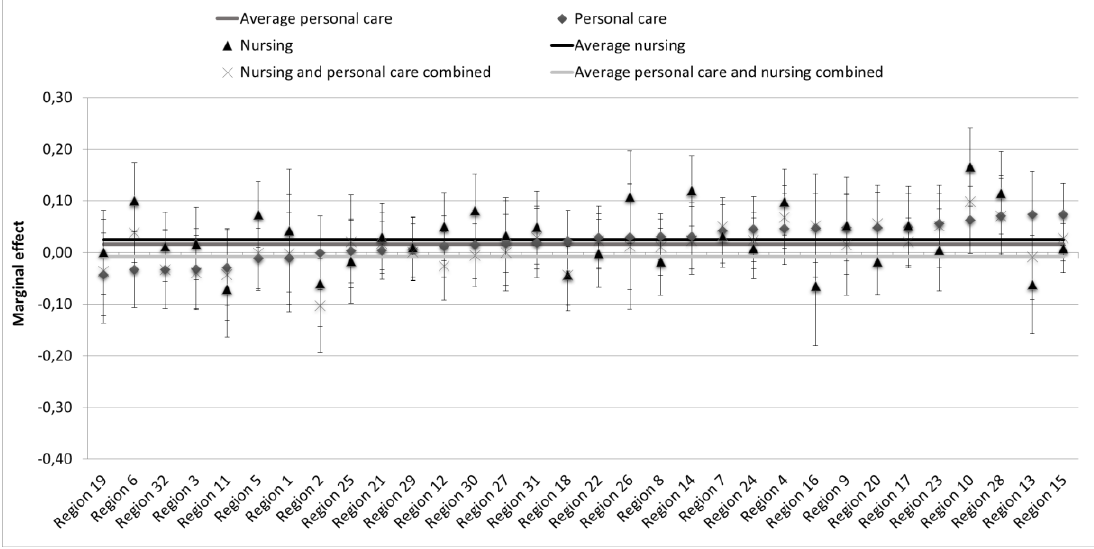
Figure A1: Variation in homecare entitlements granted for both 65- and 65+